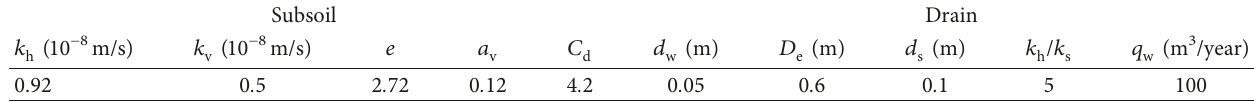
Table 2: Subsoil and drain